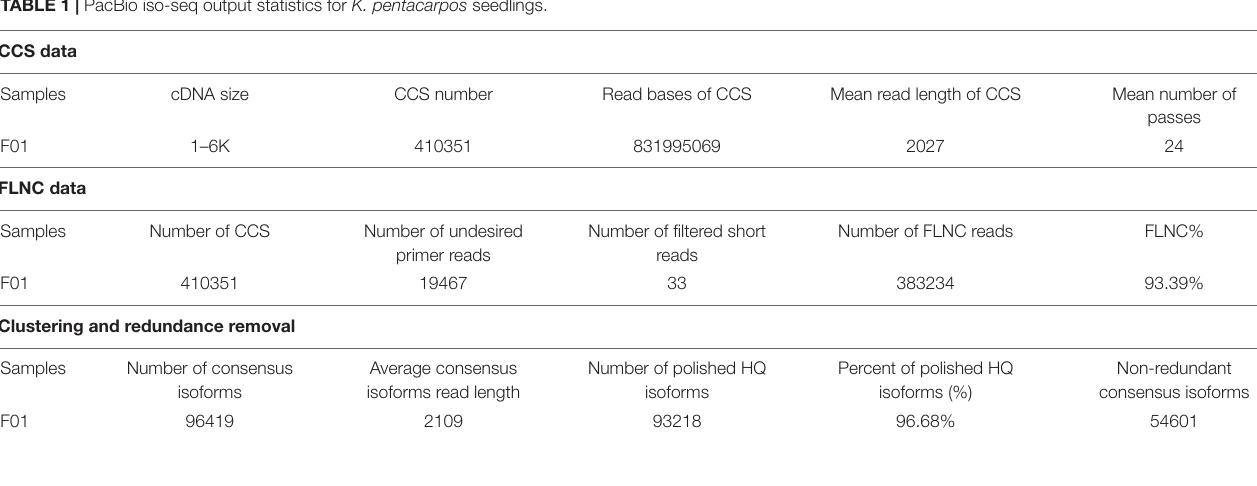
TABLE 1 | PacBio iso-seq output statistics for K. pentacarpos